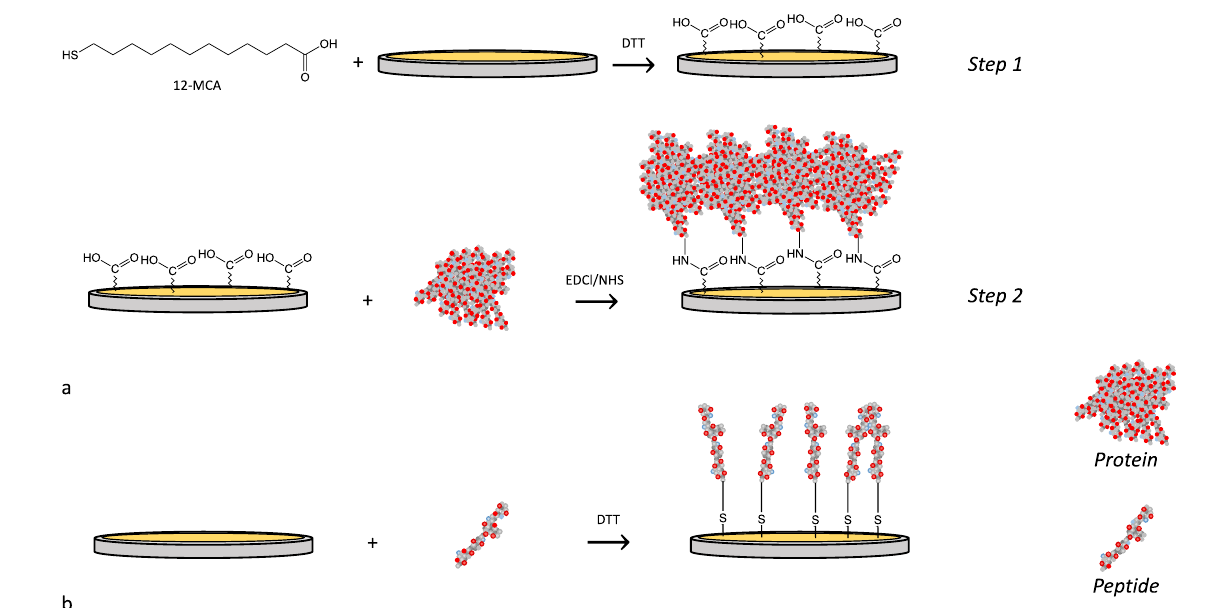
Figure 1. QCM-D functionalization strategies: ( a ) two-steps functionalization with proteins, ( b ) functionalization with peptides.